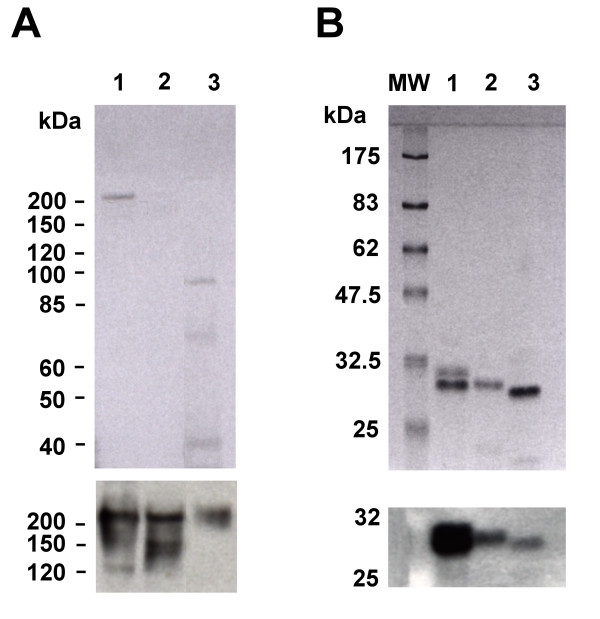
Western blot analysis of egg extracts and purified nucleoplasmin proteins. A) SDS-PAGE of heat soluble egg extracts from: Lane1, X.laevis; lane 2, B. marinus; lane 3, R. catesbeiana. Egg extract aliquots were mixed with an equal volume of 2 × SDS sample buffer and loaded in the gel without any previous boiling. Under these conditions the nucleoplasmin protein retains its pentameric conformatiom [25]. Molecular weights are a PageRuler Protein Ladder (Fermentas Life Sciences, Burlington, ON) B) SDS-PAGE of nucleoplasmin proteins purified from the extracts of: Lane1, X. laevis; lane 2, B. marinus; lane 3, R. catesbeiana. Samples were boiled in SDS (0.1%) sample buffer for 10 minutes before loading on the gel to separated nucleoplasmin proteins into their monomeric forms. MW is a prestained broad range molecular weight protein marker (New England Biolabs, Ipswich, MA). Western blot analysis was done using a polyclonal antibody elicited against recombinant X. laevis nucleoplasmin [28] and the results are shown in the lower panels of both A) and B) below the corresponding gels.